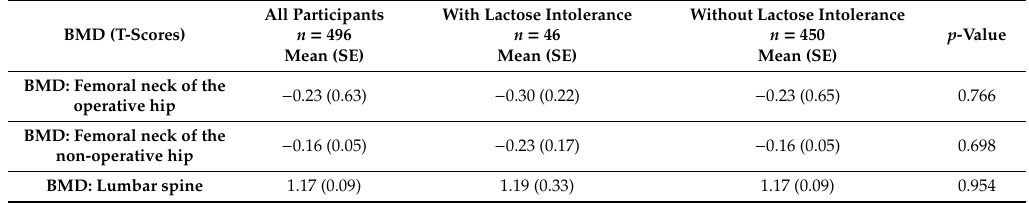
Table 3. Di ff erences in bone mineral density (BMD) t-scores according to lactose intolerance status.